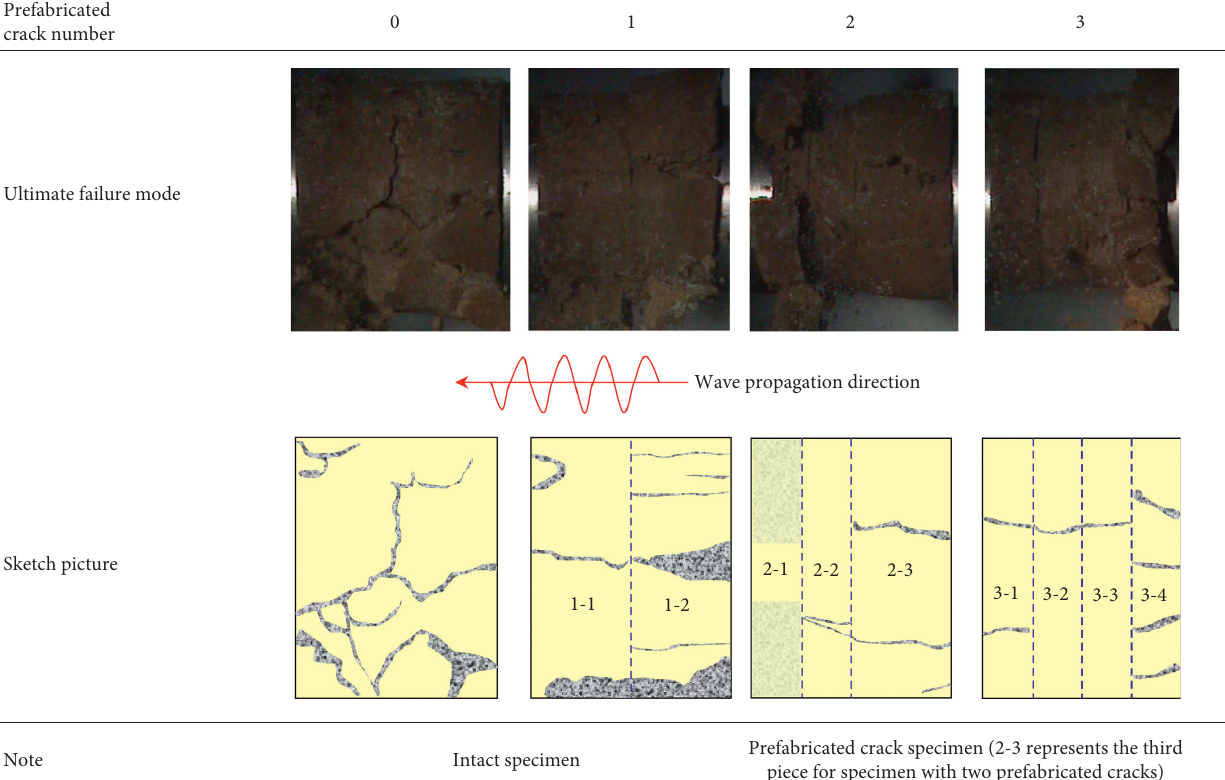
Table 3: Ultimate failure mode of intact and prefabricated crack frozen silty soil specimens.